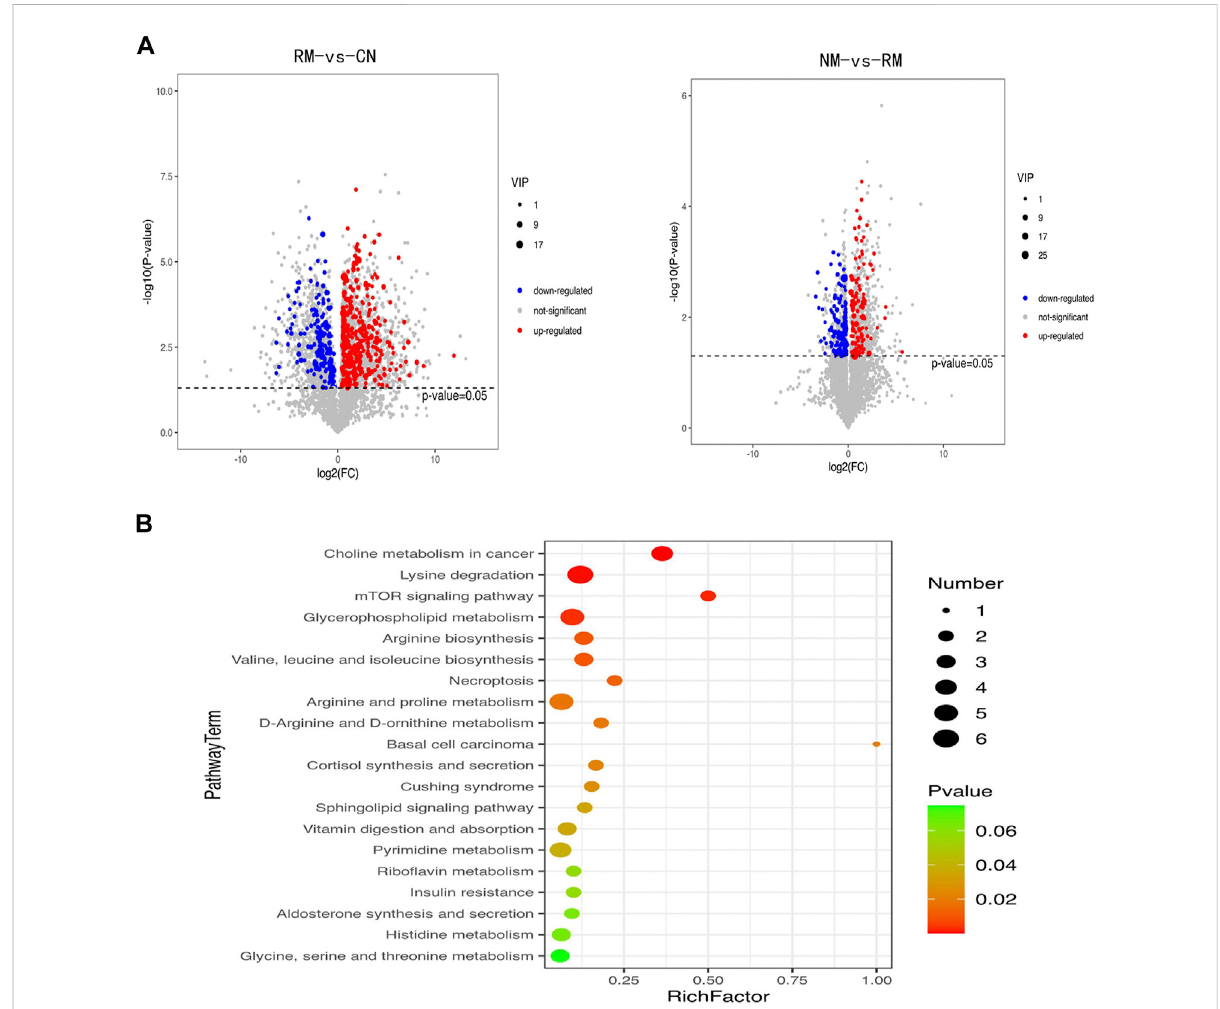
FIGURE 9 (A) Volcano plot of differential metabolites in RIAKI. X axis and Y axis represent log 2 (fold change) and p -value, respectively. Red and green dots represent upregulated and downregulated metabolites, respectively. (B) KEGG pathway enrichment analyses of differential metabolites. (B) The top 20 are presented. The enrichment factor is the ratio of the number of DEGs to the number of total genes in a particular pathway. The dot size represents the number of differential metabolites, while colors correspond to the range of p